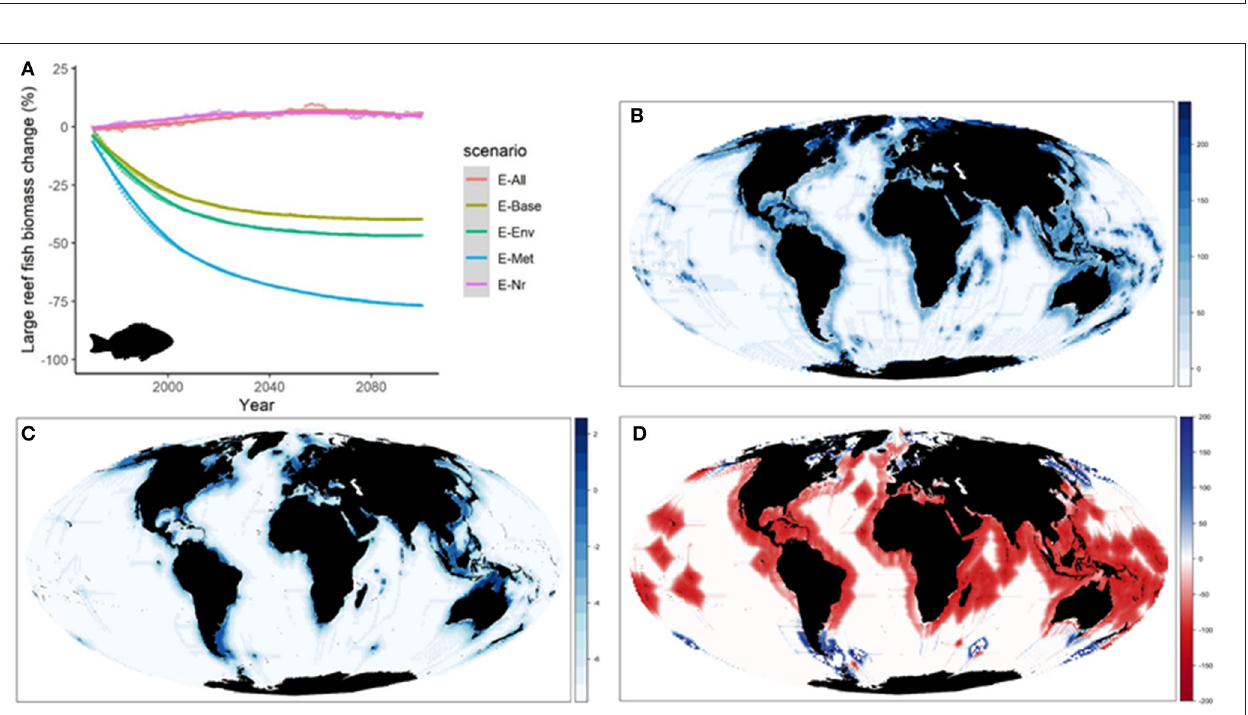
FIGURE 3 | Experiment 1 (Ecological configurations, Table 1 )—Spatial changes of Total Consumers Biomass: (A) Mean spatial values across the different ecological configurations and (B) spatial results under configuration E-All in 2001–2005. (C) Coefficient of variation and (D) relative change across the different ecological hypotheses. For visualization purposes, maps (A–C) plot values between the first and third quantile.